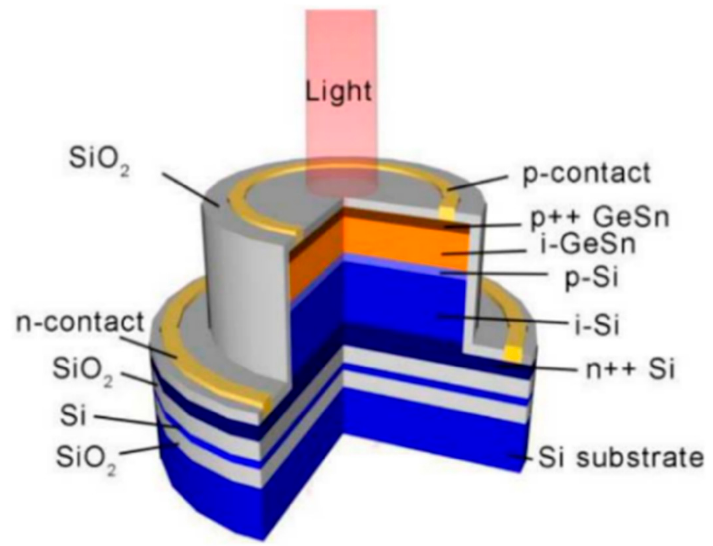
Figure 19. Proposed RCE GeSn SPAD structure with GeSn absorber and Si multiplication layer. Reproduced with permission from [76], IEEE, 2021.